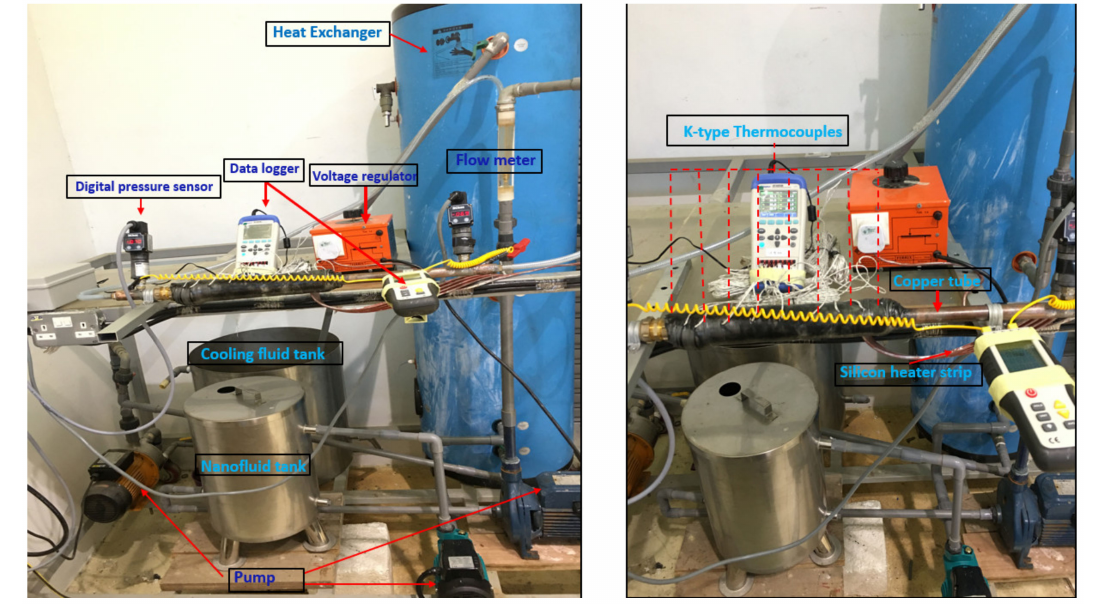
Figure 9. Experimental set-up.